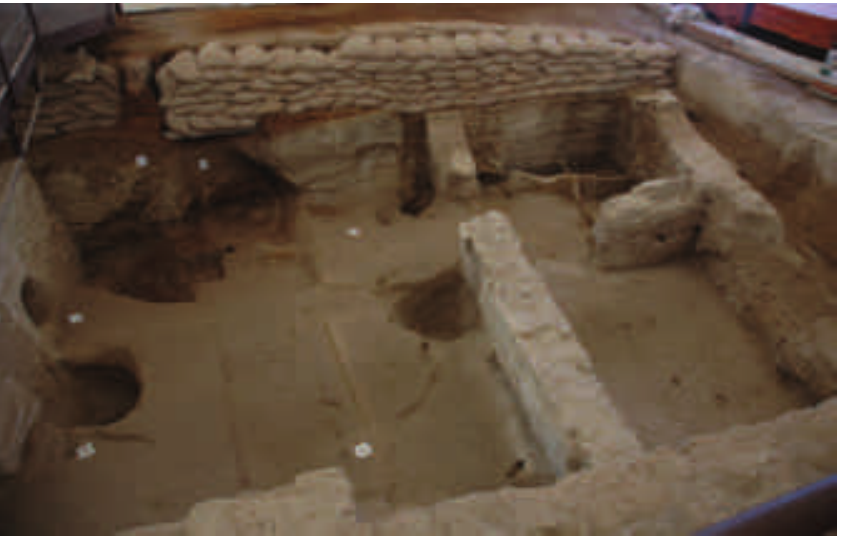
Figure 2 Building 5, still going strong after ten years’ exposure and regular re-treatment